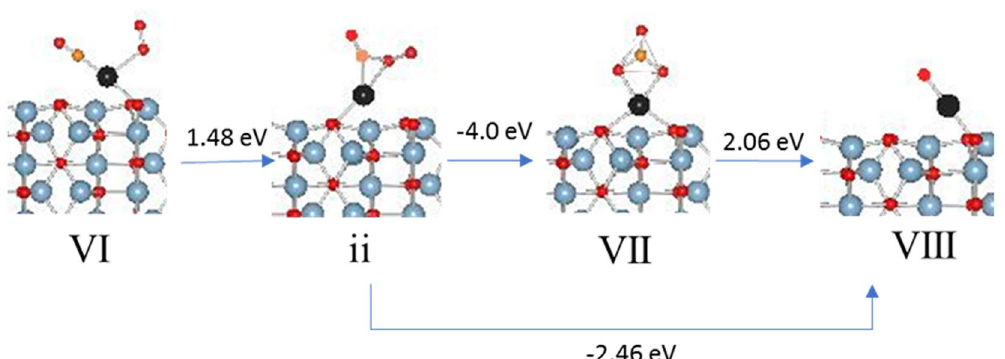
Figure 4. Energetics of CO 2